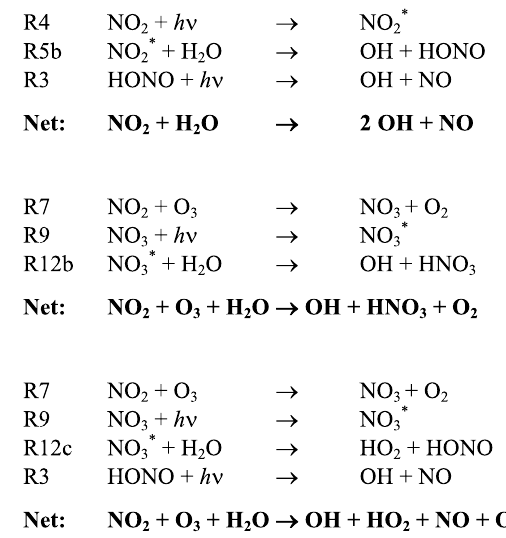
Figure 2. Net effects of reactive removal of NO ∗